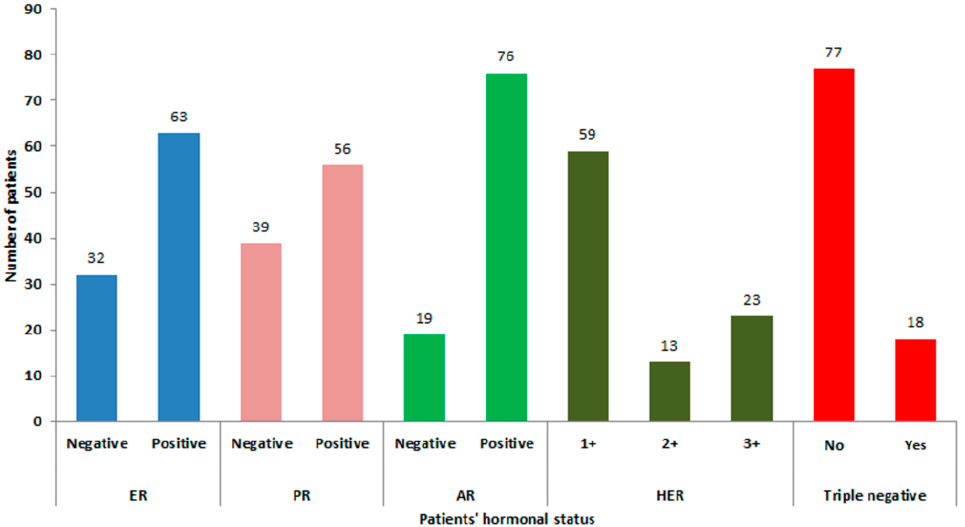
Figure 3. Hormonal status of Thai breast cancer patients in this study. ER: estrogen receptor; PR: progesterone receptor; AR: androgen receptor; HER: human epidermal growth factor receptor.